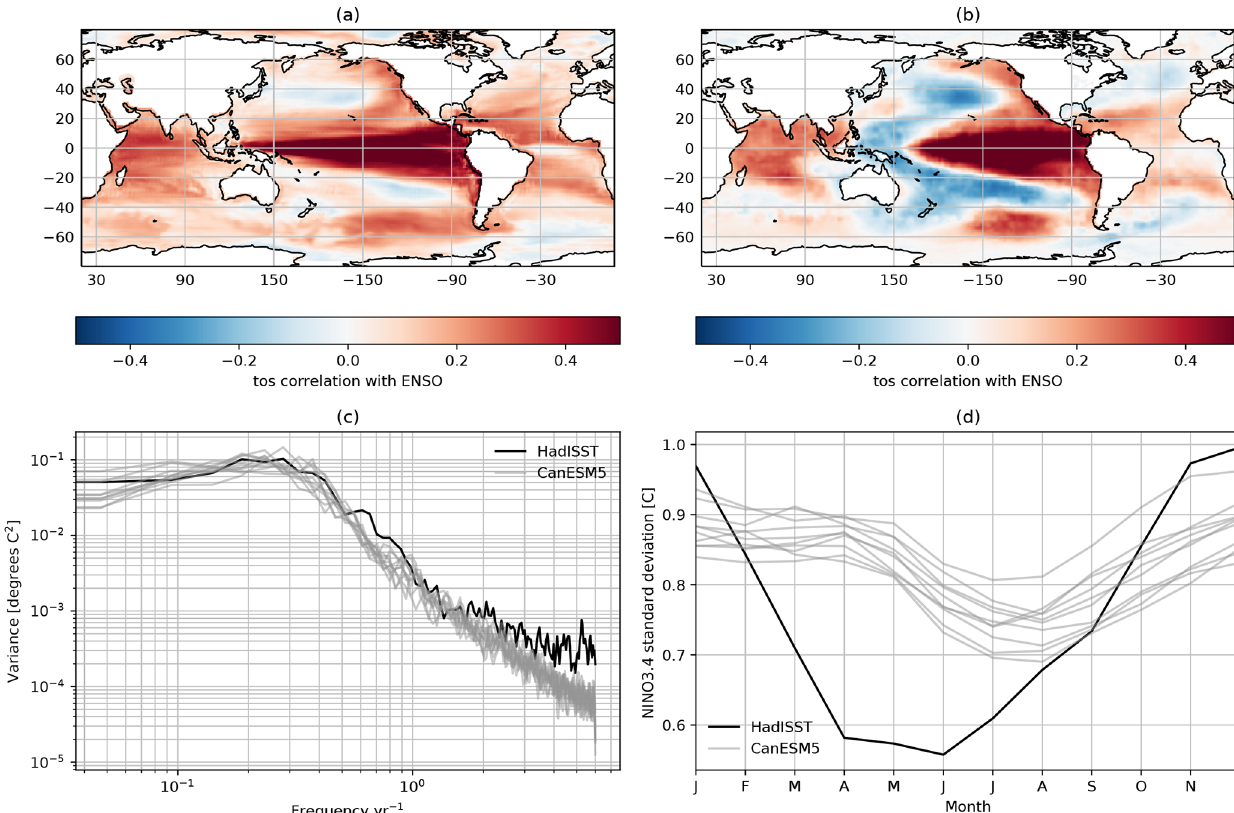
Figure 23. Characteristics of ENSO from and the HadISST observational product. Spatial maps in panels (a) and (b) are the regression of the SST monthly anomalies from 1850 to 2014 against the NINO3.4 index from (a) CanESM5 (historical ensemble member r1i1p1f1) and (b) HadISST. Temporal variability is summarized as power spectra (c) of the NINO3.4 index from HadISST and 10 historical ensemble members and the interannual variability of the NINO3.4 index by month (d) for CanESM5 and HadISST.